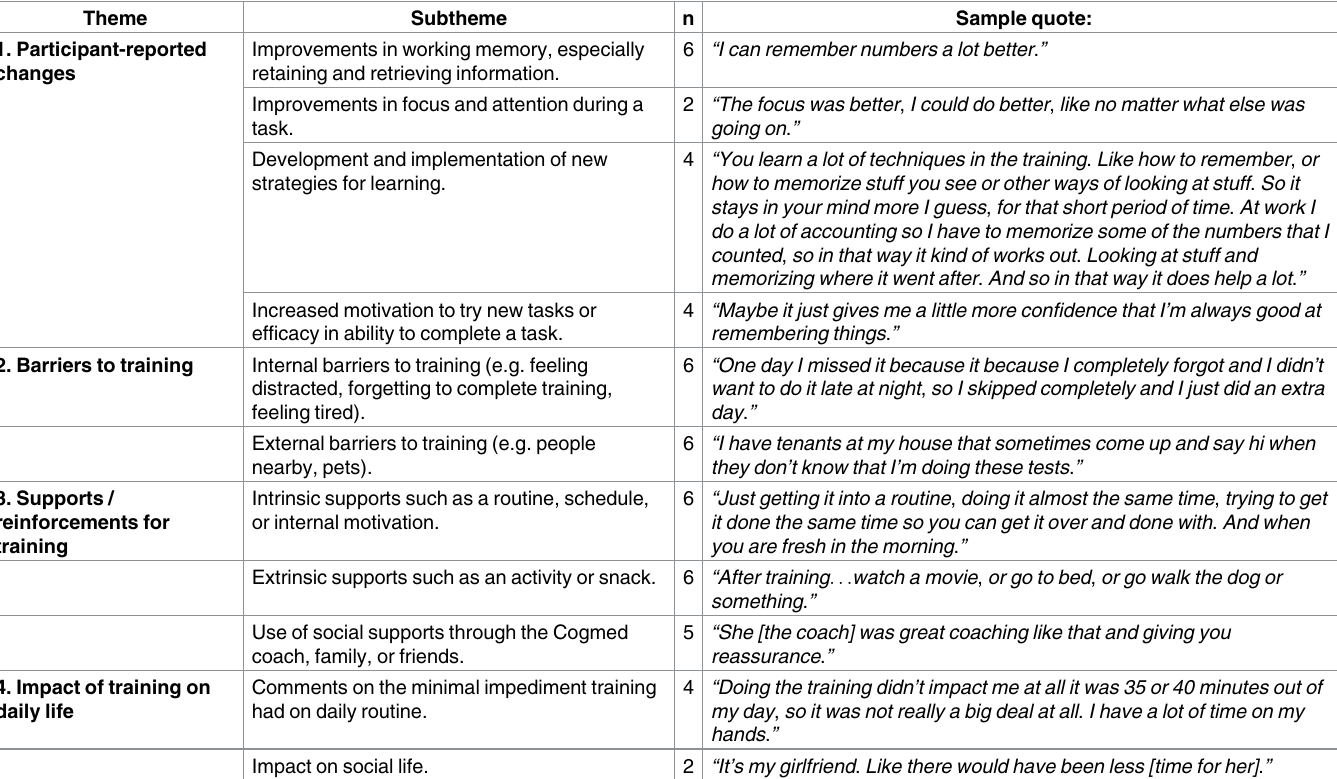
Table 5. Qualitative patient experiences summarized by sub-themes: 1) participant-reported change, 2) barriersto training, 3) supports/reinforce- ments for training, and 4) impact of training on daily life). Frequencyfor which subthemes were endorsed by the participants and sample quotes associ- ated with each subtheme are